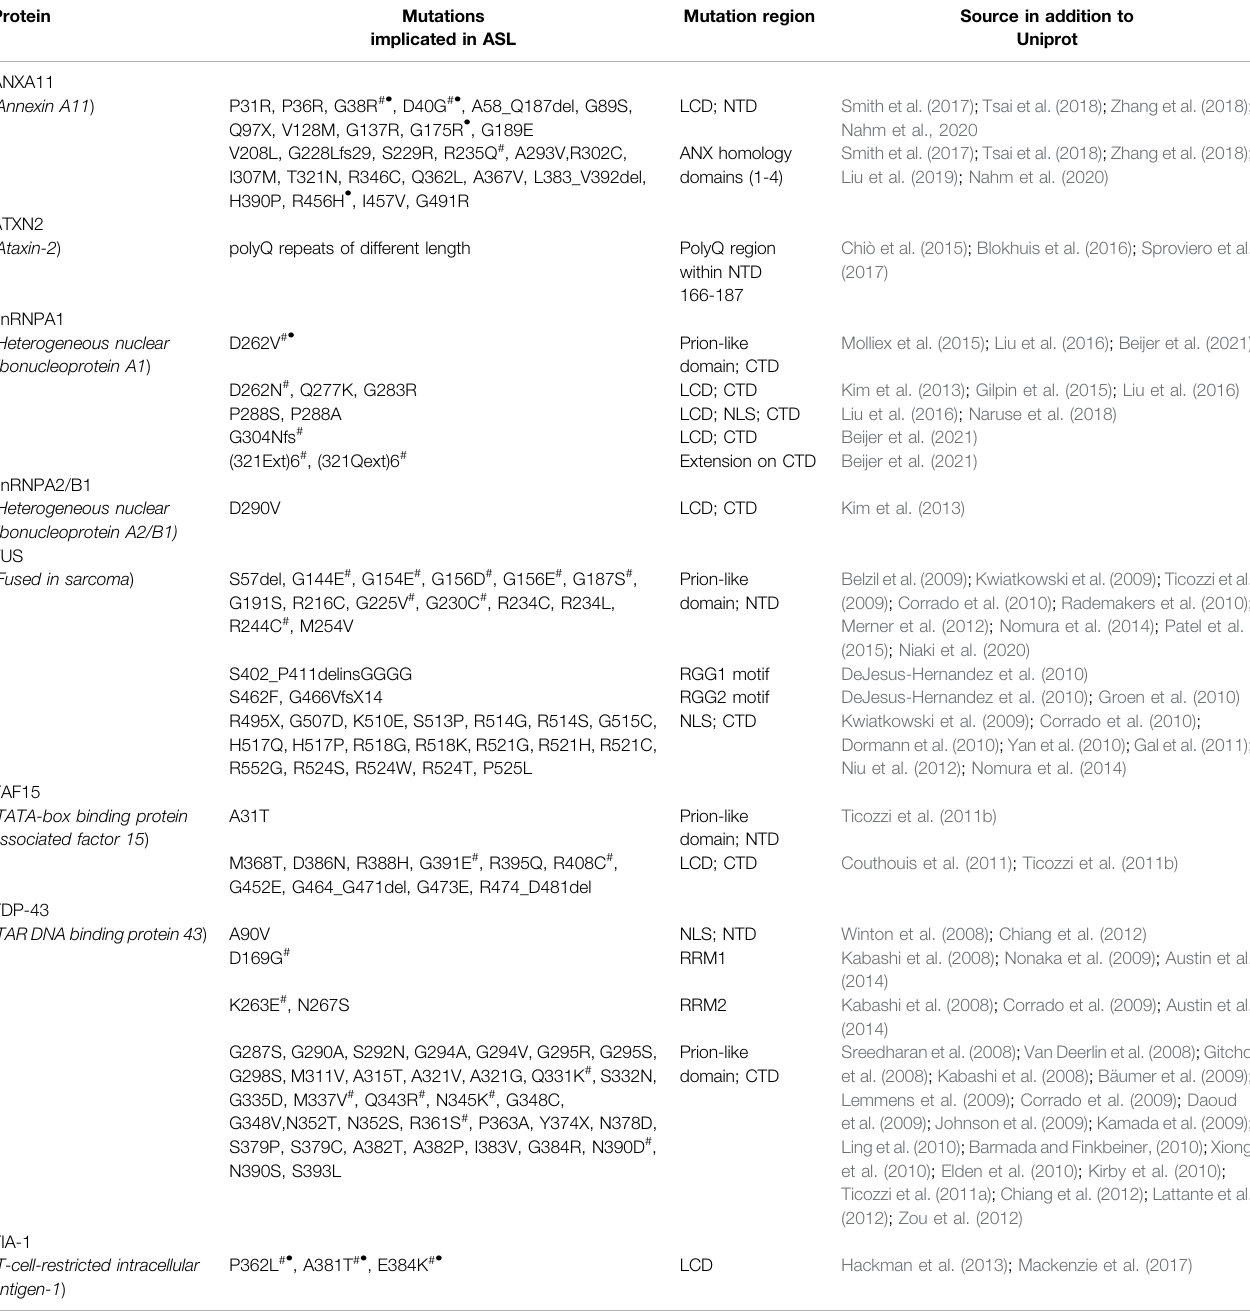
TABLE 1 | An overview of ALS-linked mutations in LLPS-related proteins. Protein Mutations implicated in